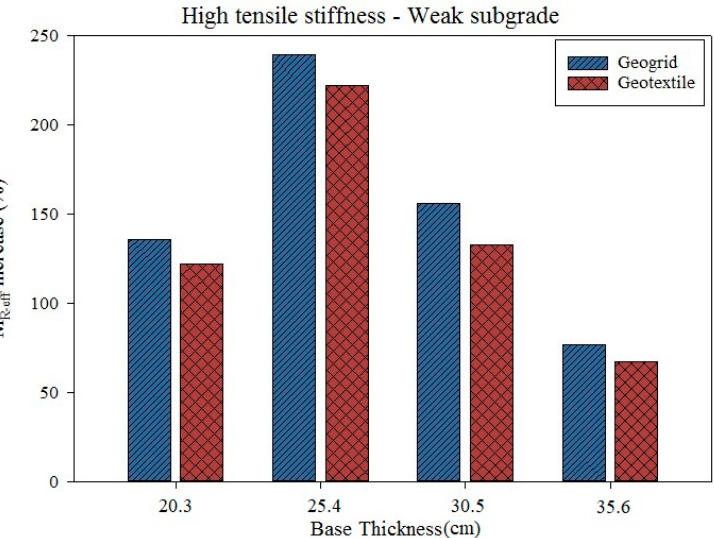
Figure 13. Changes in M R-eff increase of pavement reinforced with high tensile stiffness geosynthetics on weak subgrade soils for different geosynthetic types.